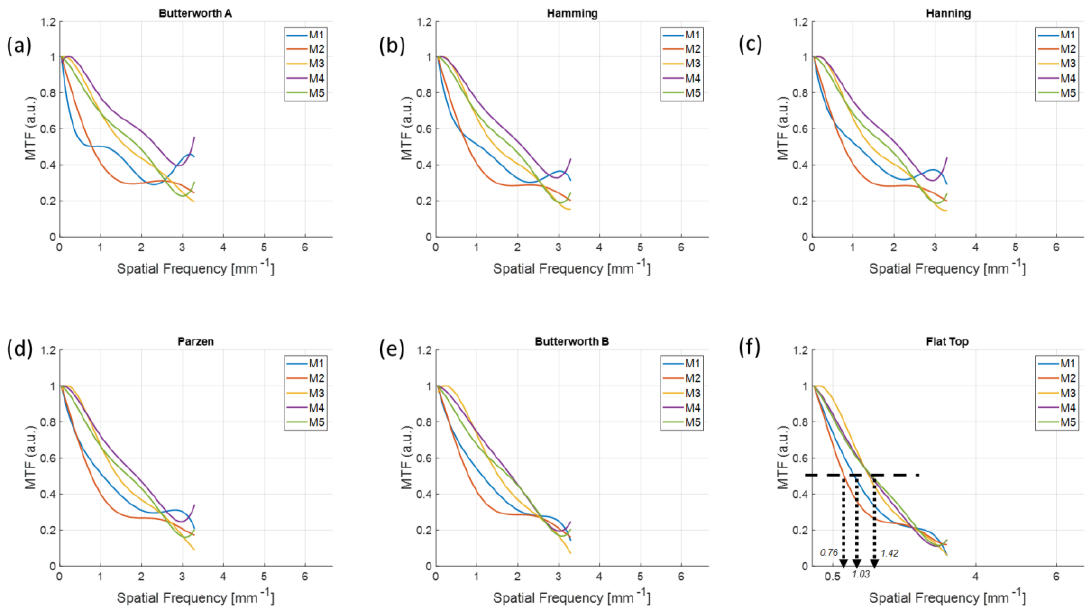
Figure 10. MTFs for different materials with the configurations (1, 1) using different filter schemes from the ( a ) Butterworth A, ( b ) Hanning, ( c ) Hamming, ( d ), Parzen, ( e ) Butterworth B, and ( f ) Flat Top windows. The orders of f 50 s as a function of different materials were different for each filter scheme.